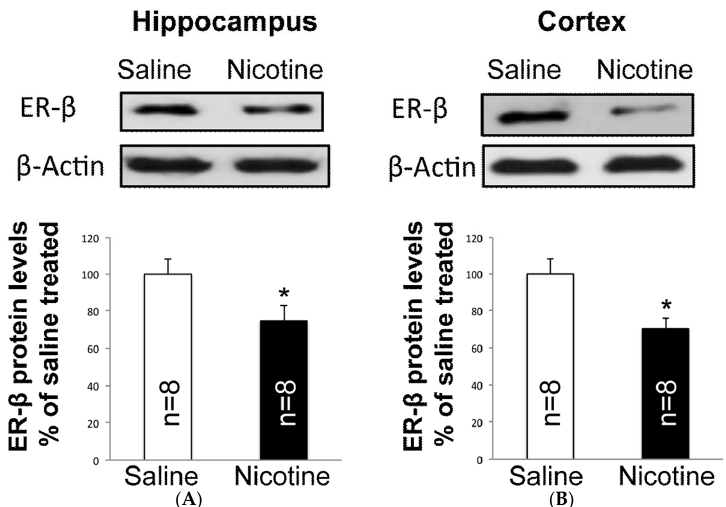
Figure 1. Nicotine decreases estrogen receptor beta (ER-β) protein expression in the hippocampus and cortex of female rats. Immunoblot analyses show significant reduction in the ER-β proteins of nicotine treated ( A ) hippocampus and ( B ) cortex when compared to the saline group. Data are presented mean ± SEM (* p < 0.05), n = 8.